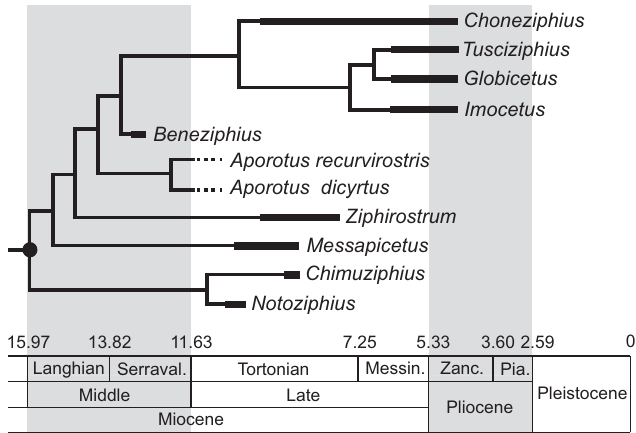
Fig. 6. Stratigraphically calibrated phylogenetic relationships within the stem ziphiid “ Messapicetus clade” (black circle). Beneziphius is the old- est described member of the group, based on the biostratigraphic dating of sediment sampled from the holotype of Beneziphius brevirostris (early to mid-Serravallian, 13.2–12.8 Ma). The unresolved phylogenetic rela- tionships of the two currently recognized species of Beneziphius are not illustrated (see comments in the text and Fig. 5). Messin., Messinian, Pia., Piazencian; Serraval., Serravallian; Zanc., Zanclean. Modified from Bianucci et al. (2016).